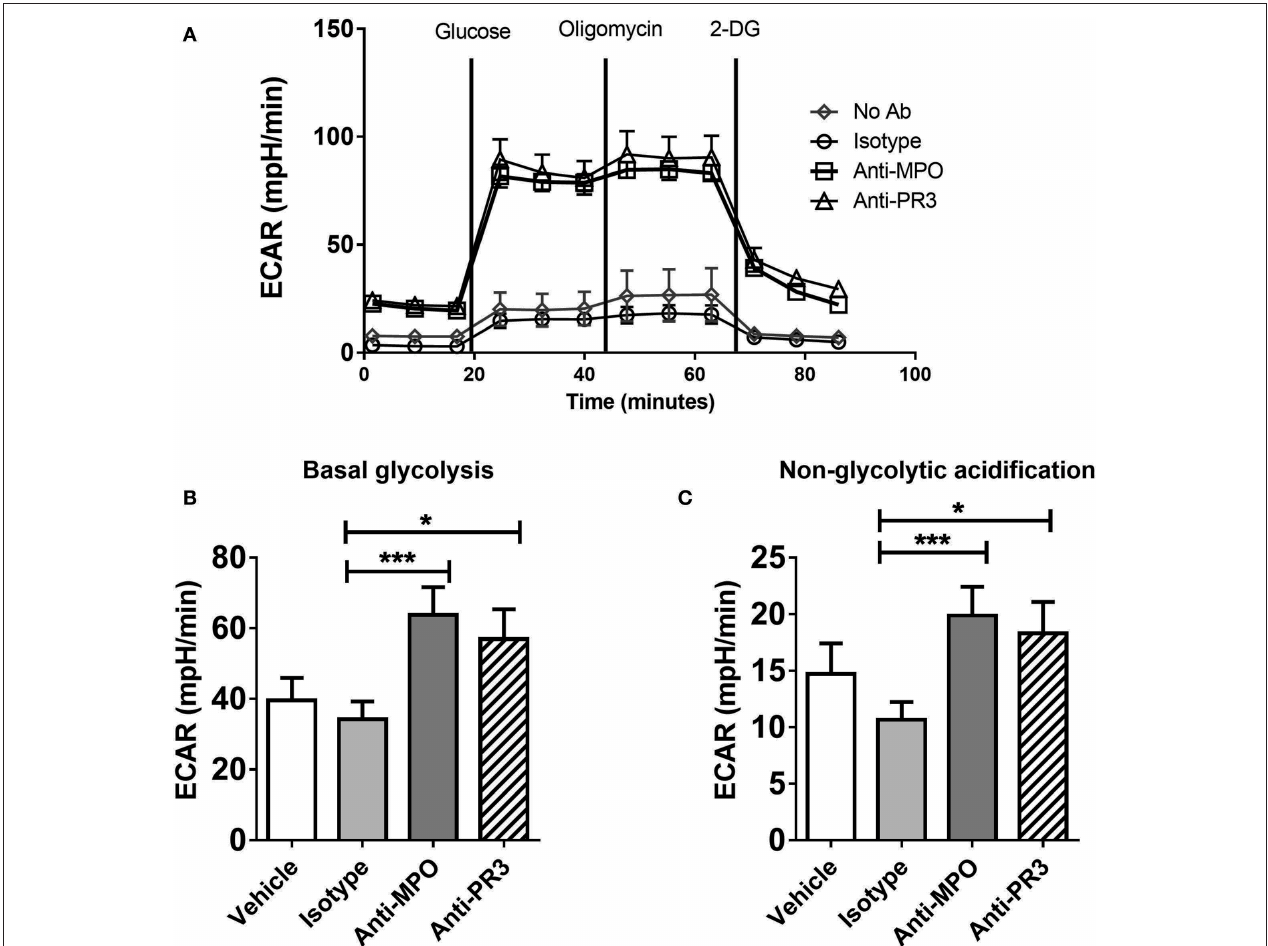
FIGURE 3 | Anti-MPO and anti-PR3 stimulation results in an upregulation of glycolysis in monocytes. CD14 + monocytes were stimulated with 5 µ g/ml mAb directed against MPO, PR3 or isotype control antibody. Extracellular acidification rate (ECAR) was measured at basal levels and following the addition of 4.5mM D-glucose, 4 µ M oligomycin and 10mM 2-DG (A) . Glycolytic rate was calculated by subtracting non-glycolytic acidification (post 2DG treatment) from the rate of acidification following the addition of glucose (B) Non-glycolytic acidification was defined as the ECAR rate after 2-DG addition (C) . Data are presented as the mean and SEM. Statistical analysis was performed by one-way ANOVA with Friedman’s post-test (* p < 0.05, *** p < 0.001) ( n =